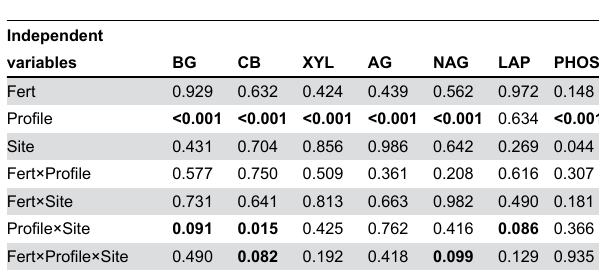
Table 4. Summary of p -values resulting from mixed-effect model analyses for activation energy as independent